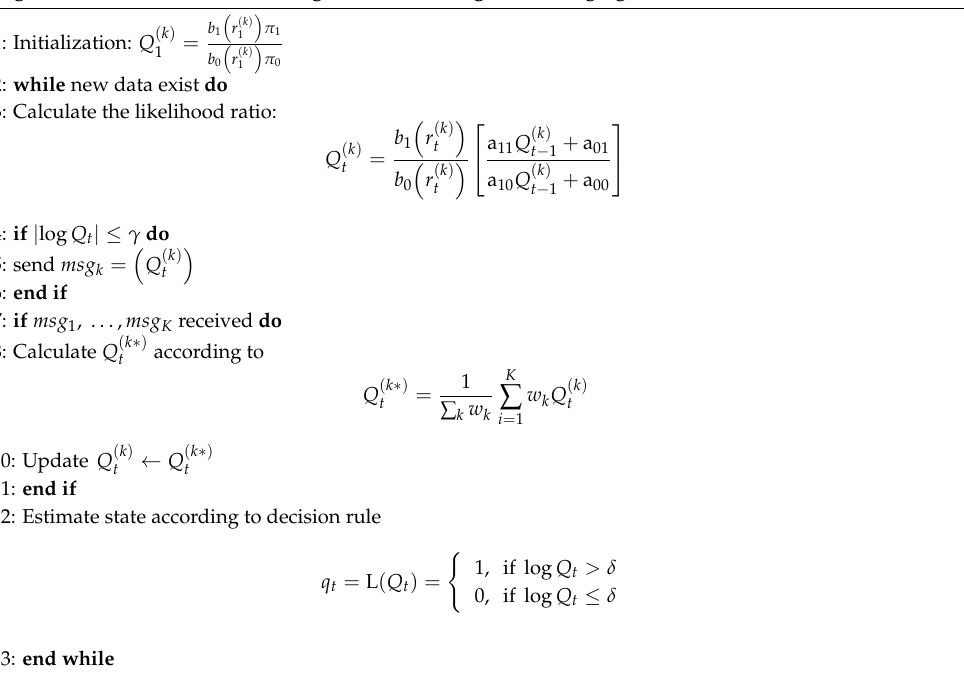
Algorithm 3: Distributed HMM Algorithm with Weighted Averaging